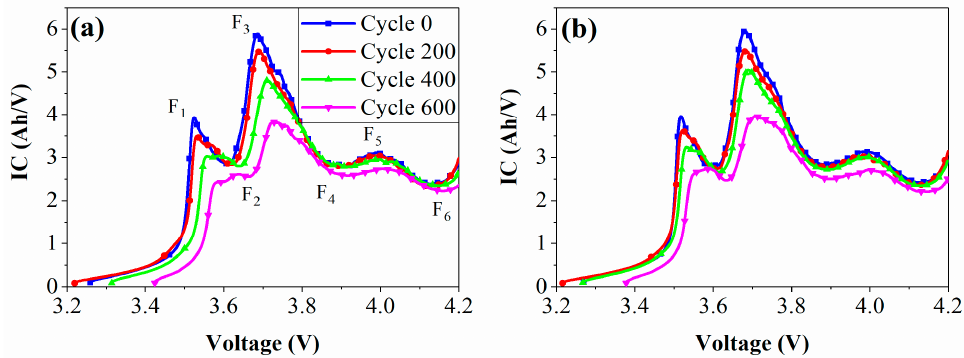
Figure 2. Battery IC curves at different aging cycles. ( a ) 0.5C-0.5C aging condition. ( b ) 0.5C-1C aging condition.